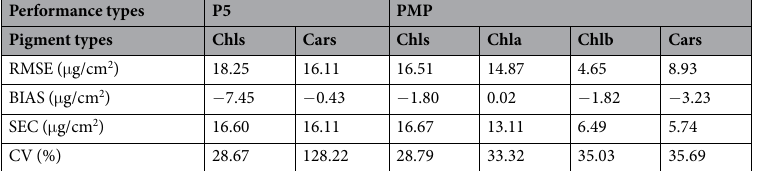
Table 3. The validation of pigment concentration retrievals from in vivo leaf spectra by P5 and PMP (n =